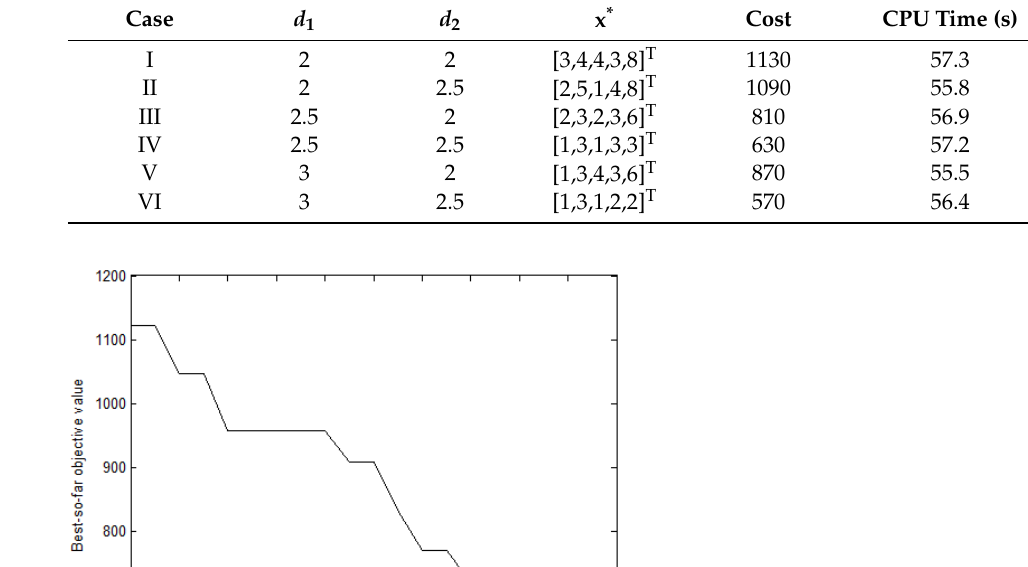
Table 4. The superior design x ∗ , cost, and CPU times of six cases.